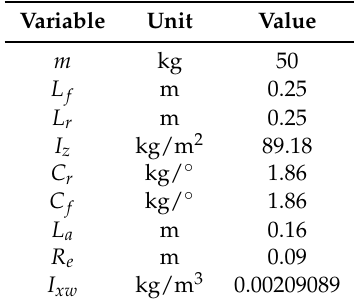
Table 1. Automated Guided Vehicles (AGVs) parameters.